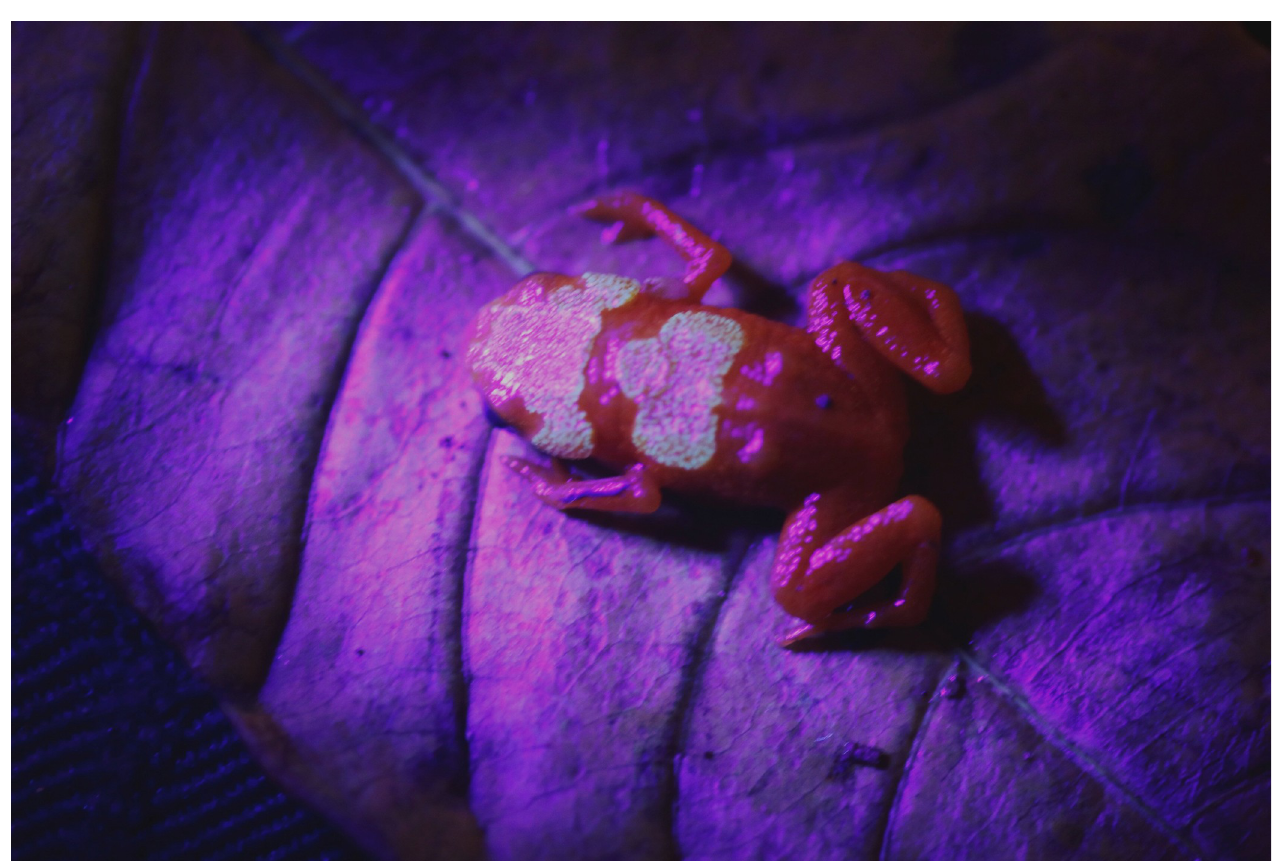
Fig 4. Brachycephalus rotenbergae sp. nov. lightened by a UV flashlight (395 nm wavelength). Deatil of fluorescence in dorsal and cephalic shields.